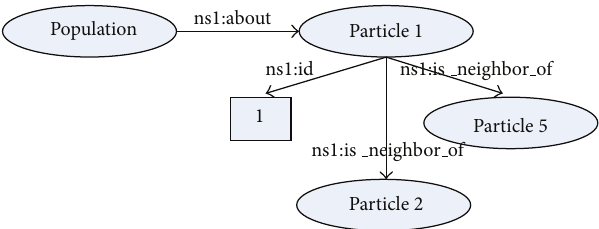
Figure 3: This PSO distributed population model contains the definitions of resources population and particle . Thus, each particle can relate to one or more neighbors and has an identification number. The former represents a reference to other particles in a swarm, while the latter is an atomic value.